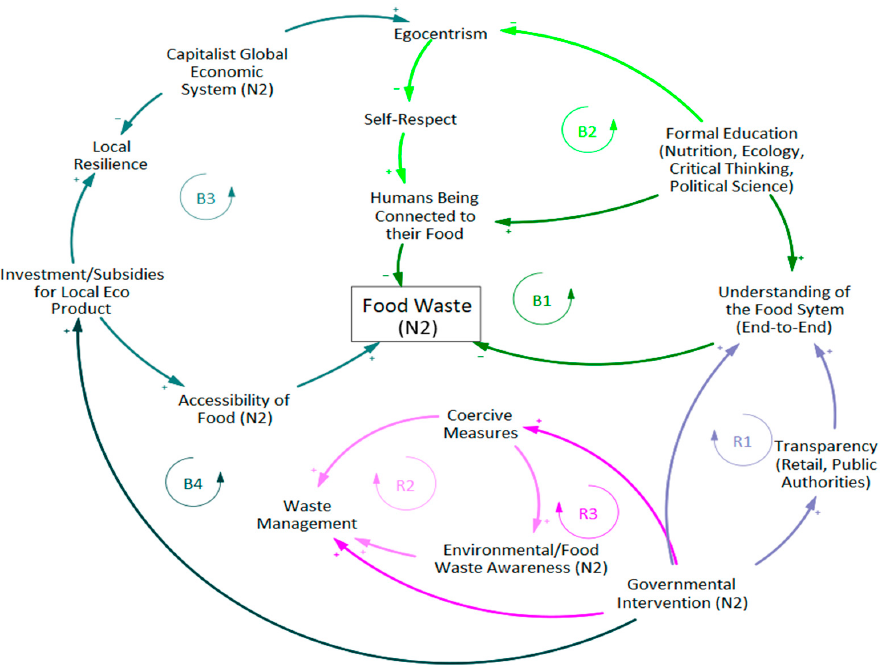
Figure A4. Food waste loop diagram elaborated during modeling session with the representative of NGO 2 (each color highlights a distinct loop).